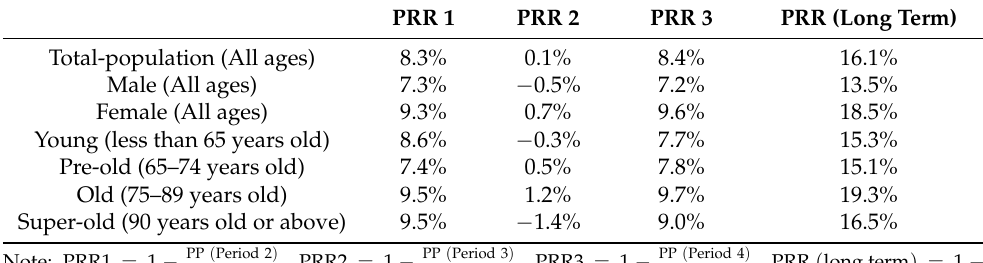
Table 3. Polypharmacy reduction ratio (PRR) over 4 years.